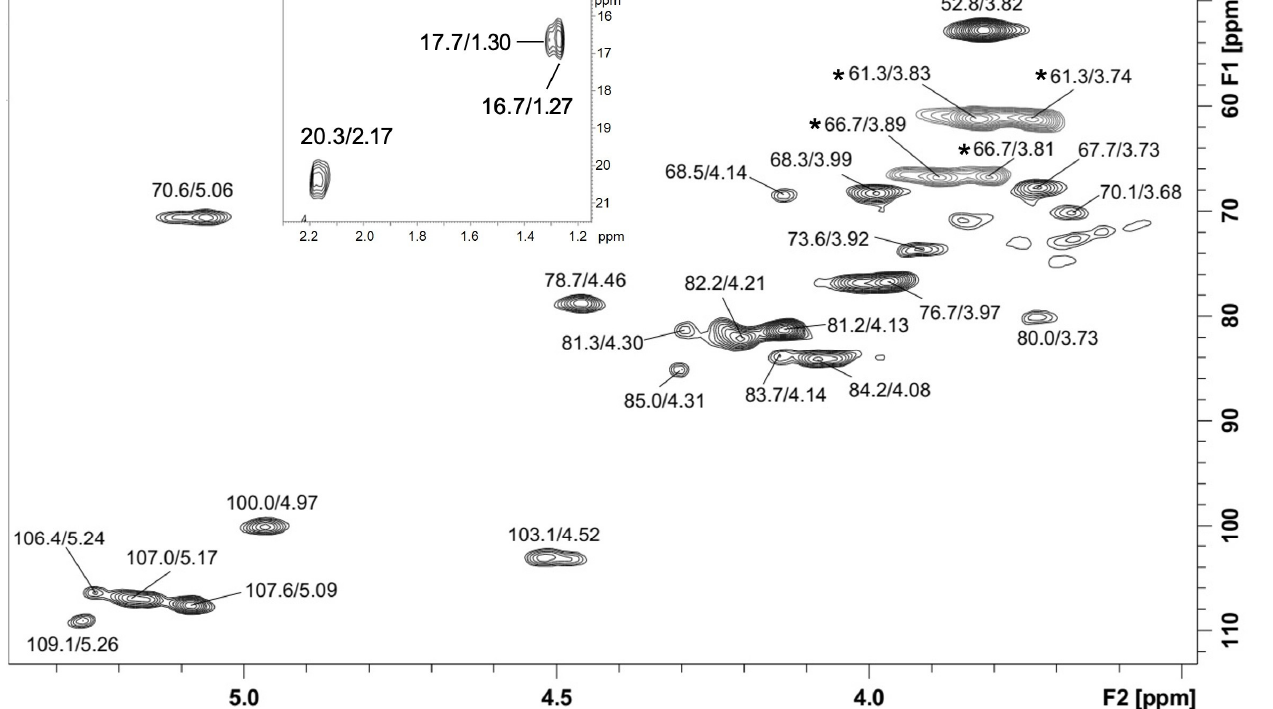
Figure 3. Chromatographic profile of S-EA fraction obtained on LC-MS analysis.